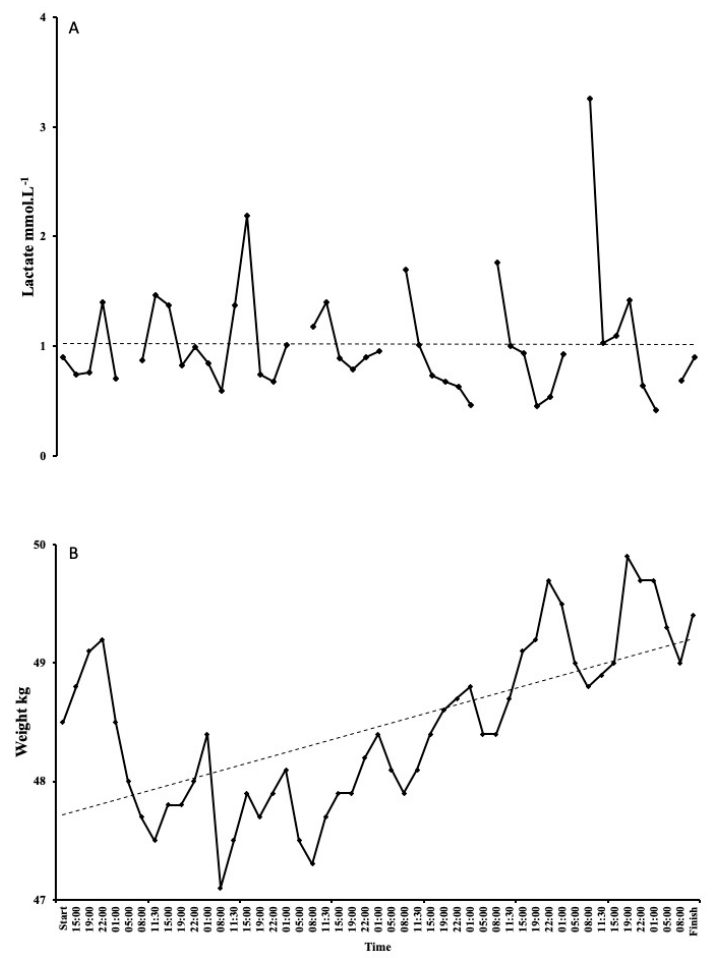
Figure 4. Changes in lactate ( A ) and weight ( B ) during the world record attempt. Lactate remained stable, with only one reading exceeding 3 mmol · L − 1 . Weight initially decreased over the first 3 days, but then continually increased, with SG finishing the event 1 kg heavier than at the start. Please note missing data are from sleep periods 1–5 a.m.